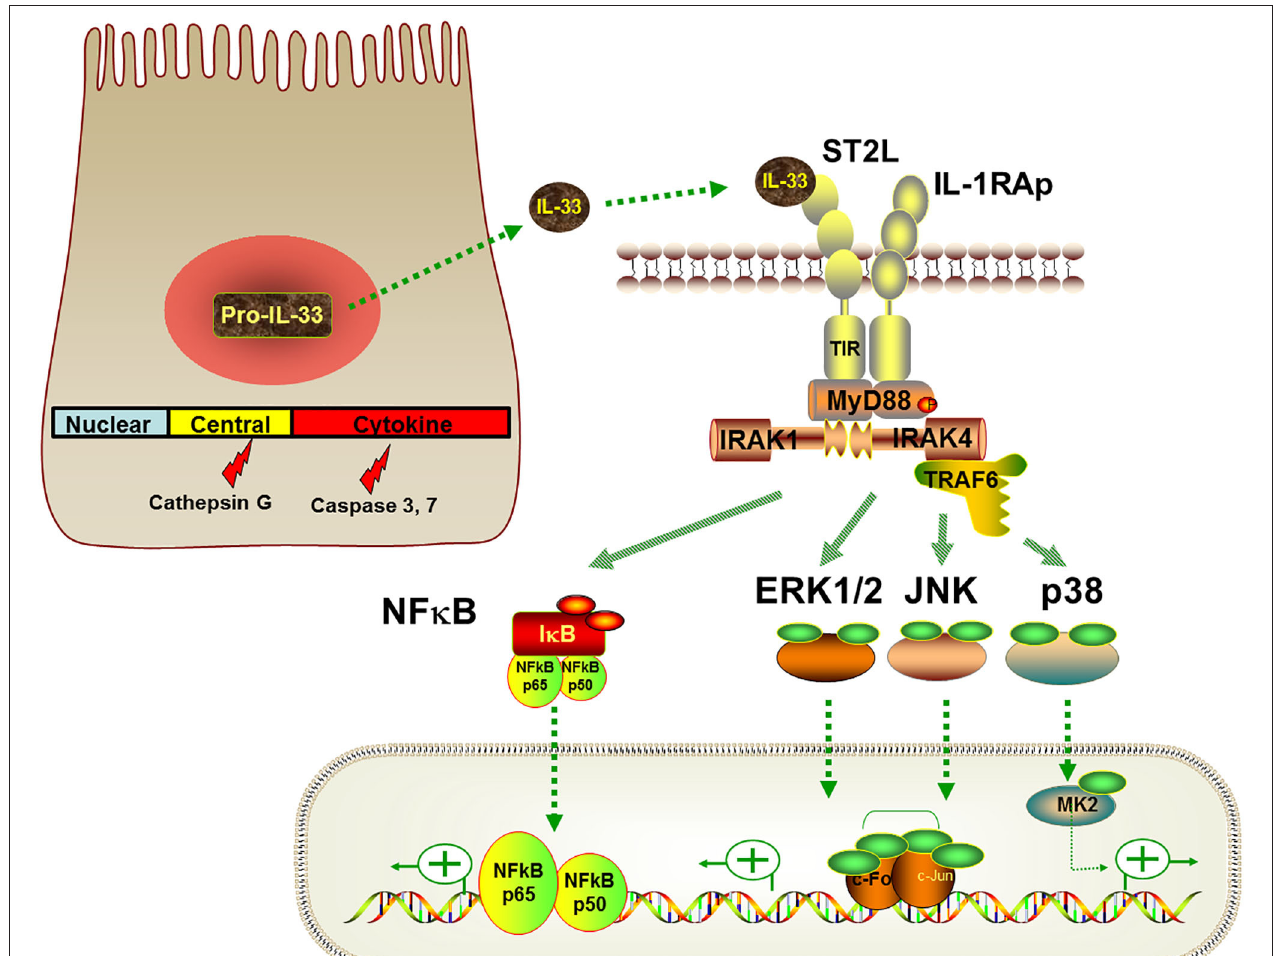
FIGURE 2 | IL-33 signaling pathways. Full-length pro-IL-33 or protease-cleaved IL-33 are released from IL-33 producing cells. Full-length IL-33 consists of a nuclear domain, a central domain and a cytokine domain. Extracellular IL-33 binds to ST2L on target cells, leading to recruitment of the co-receptor IL1RAcP to form an IL-33-ST2L-IL1RAcP complex. After recruiting MyD88, IRAKs and TRAF6, this signaling complex activates NF κ B and MAPK family members to induce downstream cellular responses that are cell- and context-dependent.